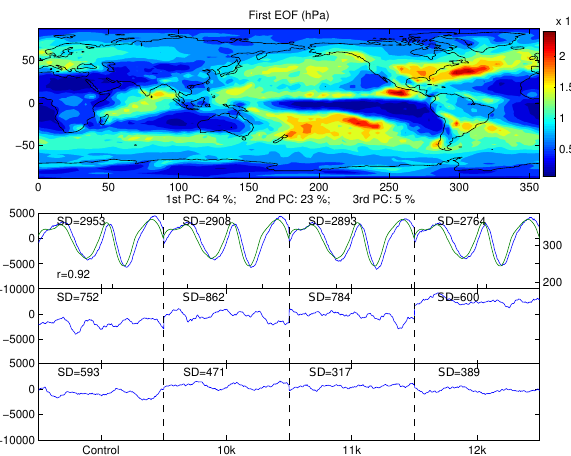
Fig. 3. The second, the third and the fourth principal component (PC) of 10 Be deposition (blue) shown with the first three PCs of pre- cipitation (green). The correlation coefficients (“ r ”) are also shown. Units are normalised.